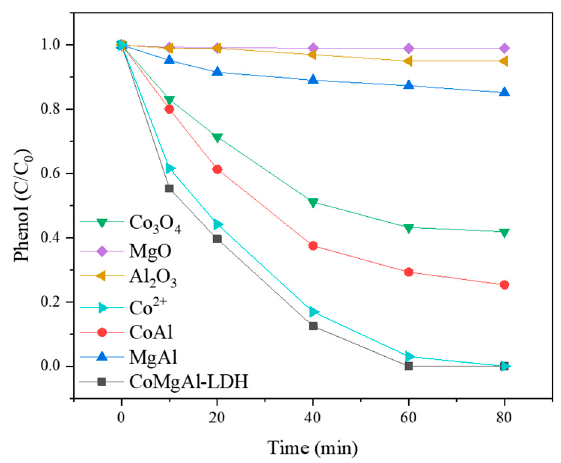
Figure 2. Degradation of phenol with CoMgAl-LDH, family oxides and compounds, and cobalt ions.